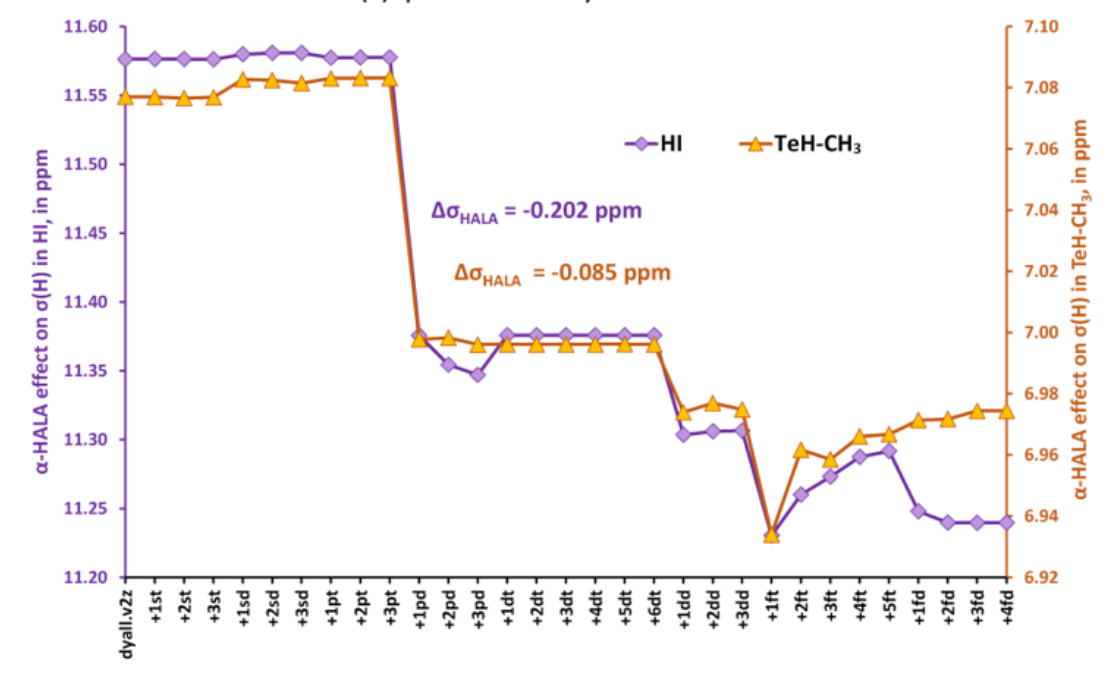
Figure 1. The change of the α -HALA effect on the proton shielding constants of HI (left vertical axis) and TeH-CH 3 (right vertical axis) upon saturation of the dyall.v2z basis set are used on the iodine and tellurium atoms, respectively.